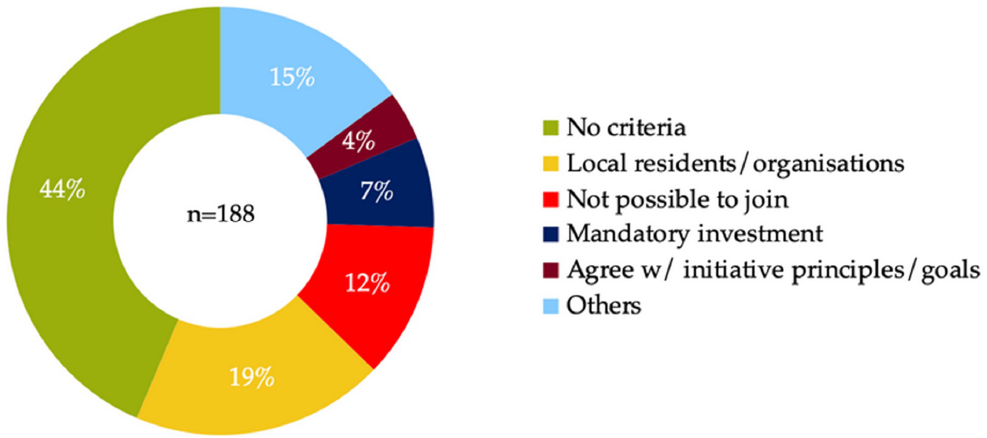
Figure 10. Criteria for joining the